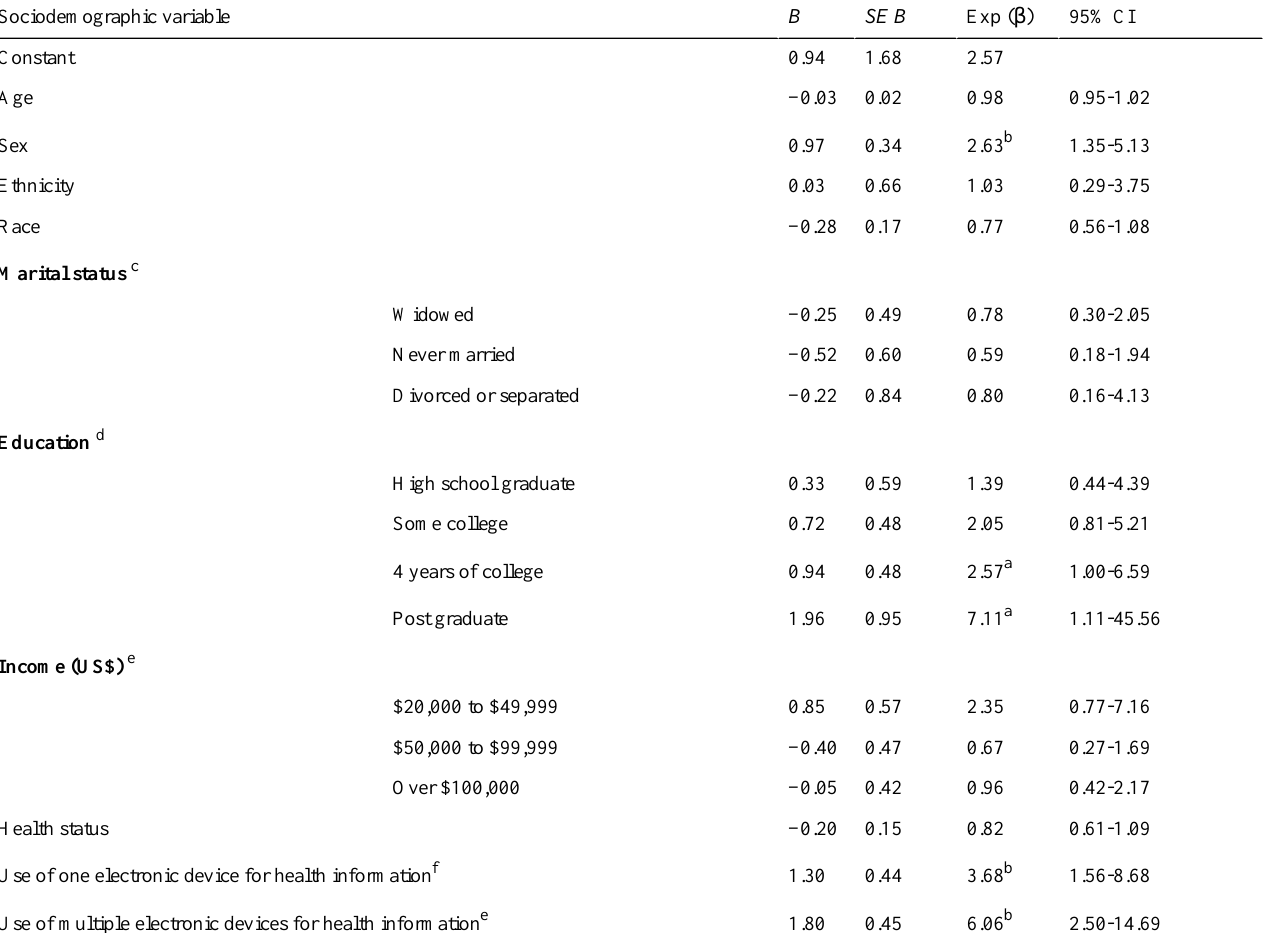
Table 4. Logistic regression predicting use of Web 2.0 for health